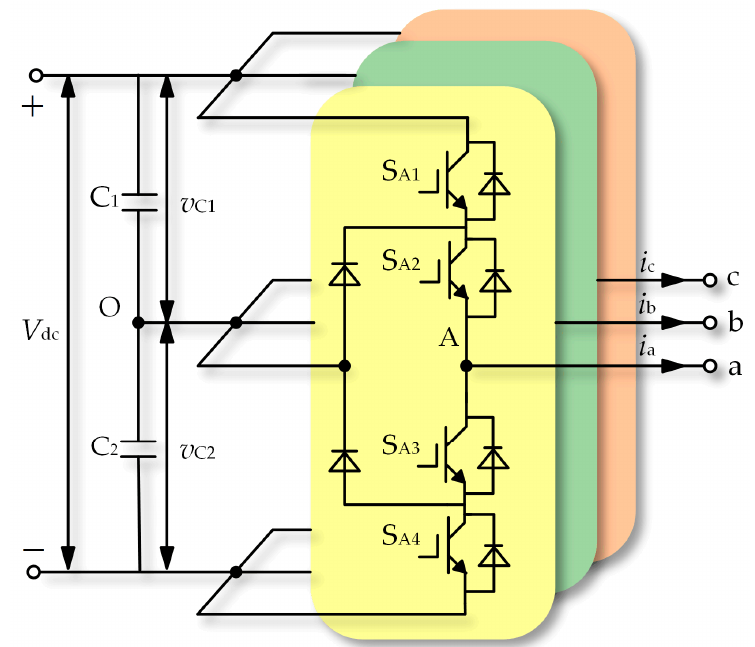
Figure 1. NPC inverter topology diagram.